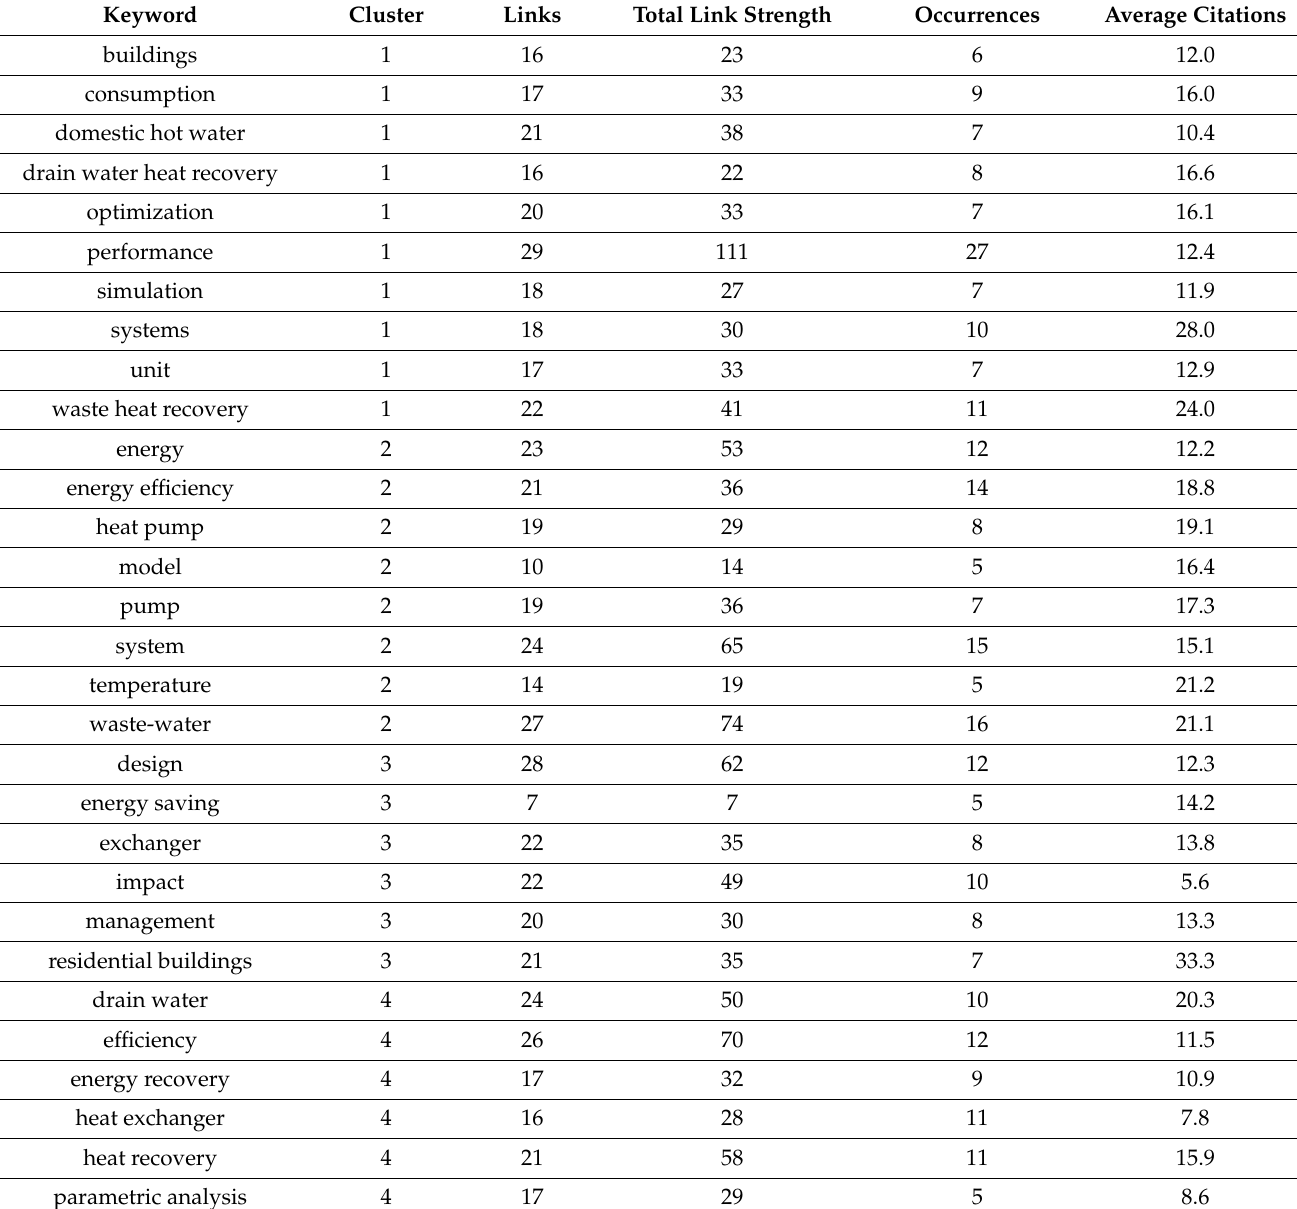
Table 5. The most popular keywords in greywater energy recovery